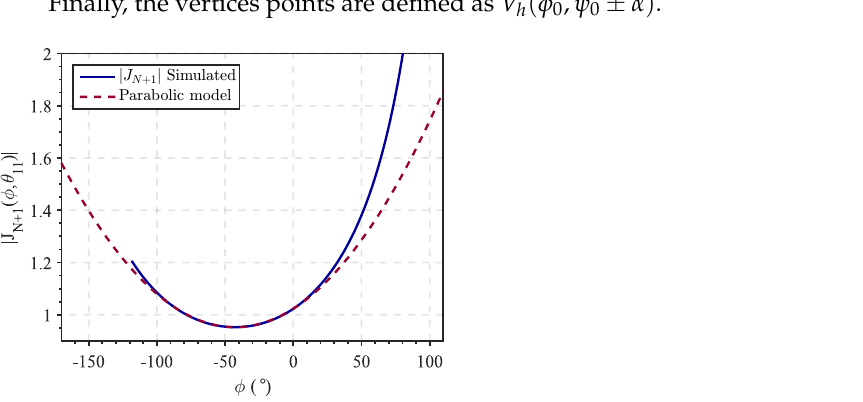
Figure 9. Comparison between the phase sweep in φ for the filter with Ω tz 1 TZs and the parabolic estimation model.